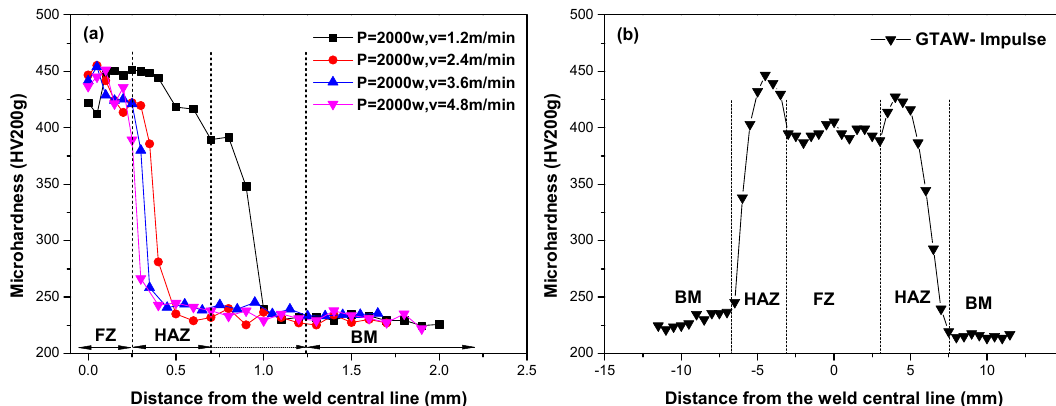
Figure 5. The microhardness distribution of ( a ) laser-welded joint and ( b ) GTA-welded joint.